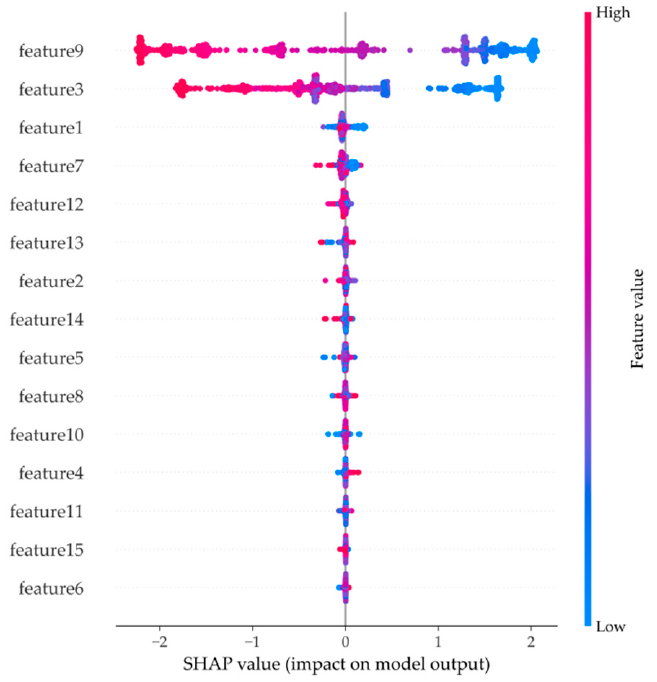
Figure 17. Random Forests (RF) algorithm screening feature results.